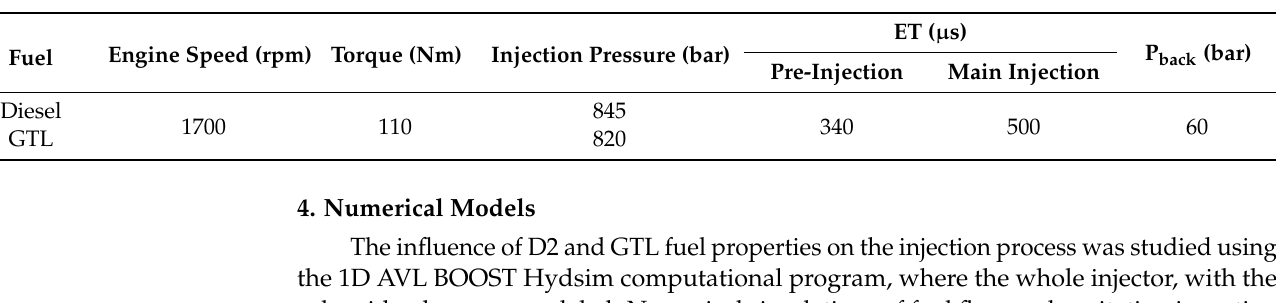
Table 2. Operating parameters.